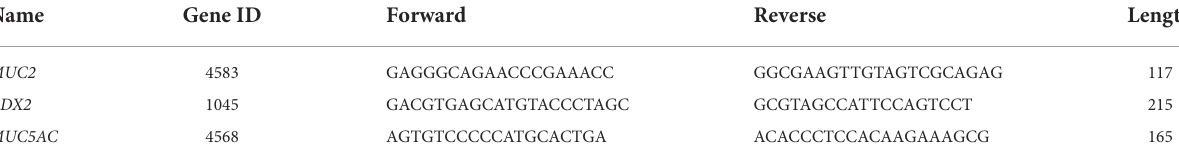
TABLE 1 Primers for